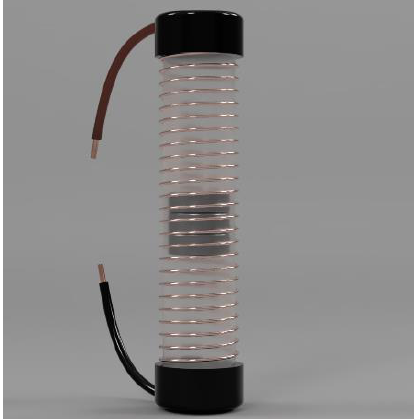
Figure 3. Microgenerator with inertial mass inside the coil (3-D rendering).